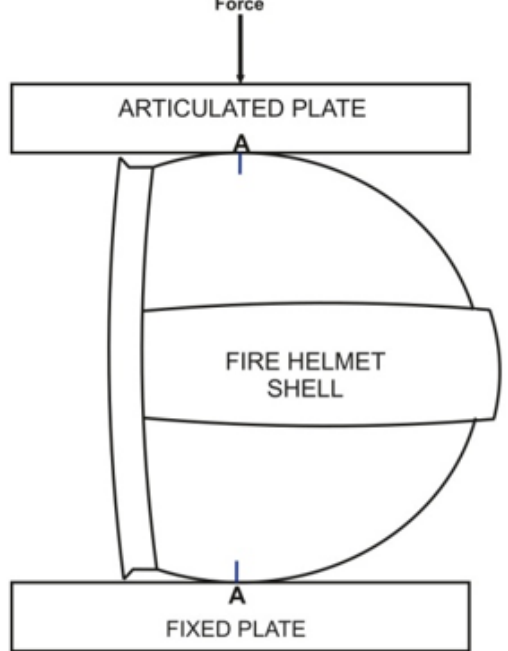
Figure 2. Scheme of testing lateral stiffness of helmet shells.